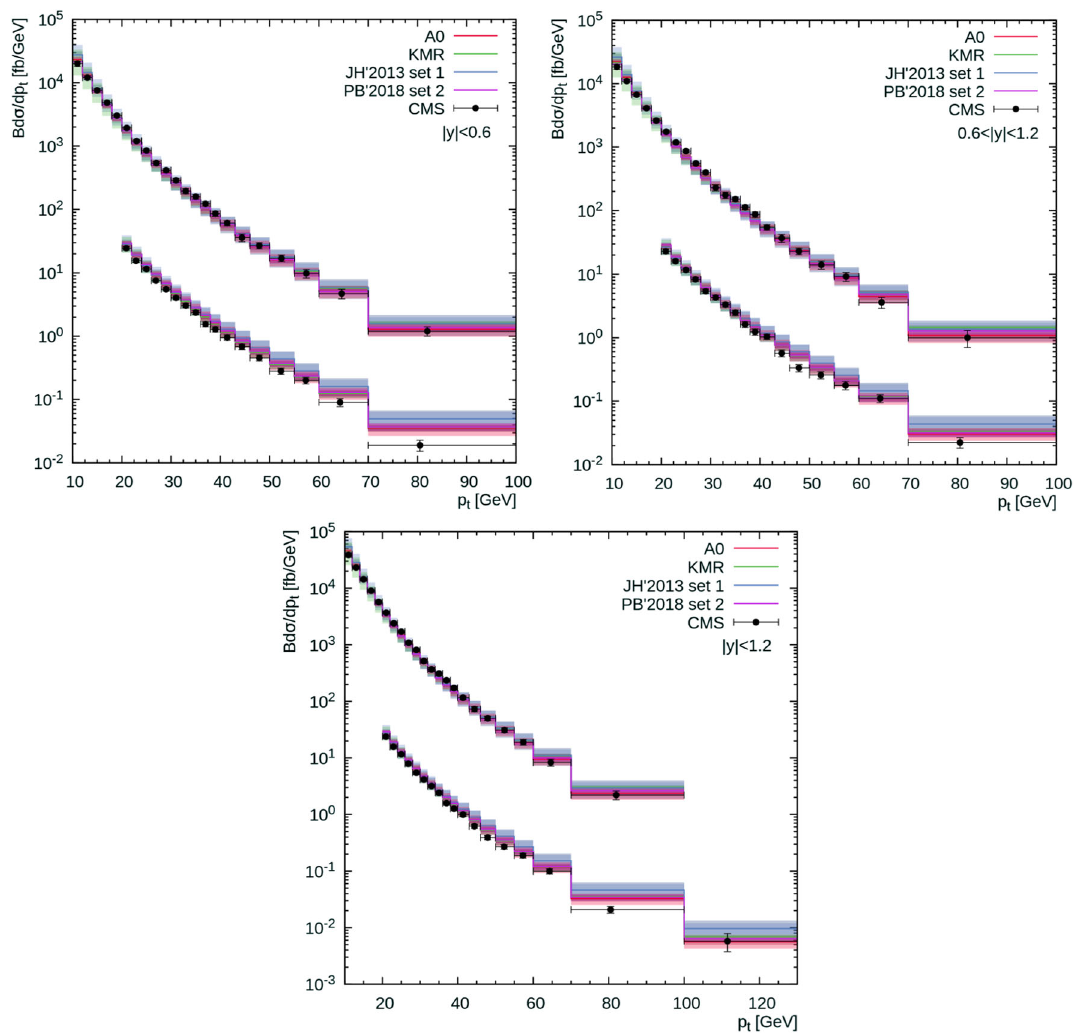
√ √ s = 7 TeV (upper histograms) and s = 13 TeV (lower